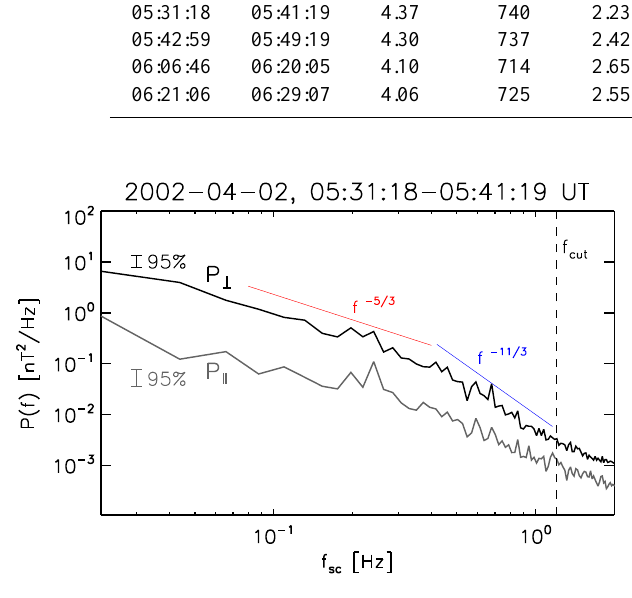
Fig. 2. Power spectra of the magnetic fluctuations parallel and per- Figure 2: Power spectra of the magnetic (cid:29)uctuations parallel and perpendicular to B 0 of the pendicular to B 0 of the second interval with spectral break around second interval with spectral break around f sc (cid:25) 0 : 4 Hz. The peak at 0 : 25 Hz is spacecraft spin f sc ≈ 0 . 4Hz. The peak at 0.25Hz is spacecraft spin frequency. frequency.